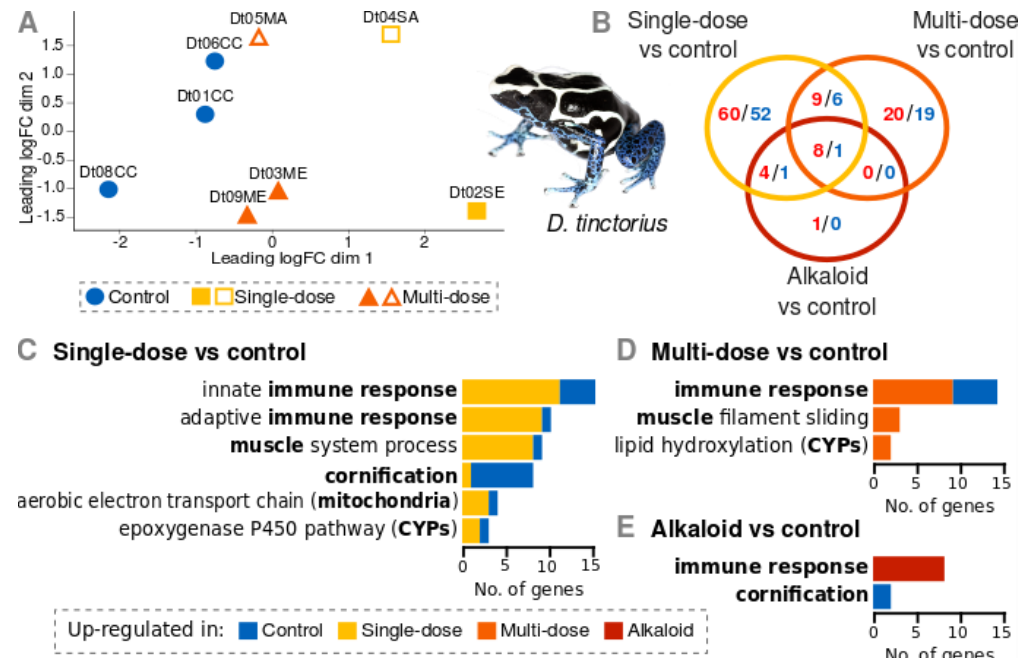
Figure 2. Gene expression of D. tinctorius upon a single dose or multiple doses of alkaloids. A. MDS plot showing the expression distances between samples coded by treatment. Distances were calculated from the logFC of the 500 transcripts with the highest standard deviations between conditions. Closed symbols = epibatidine. Open symbols = alkaloid mixture. B. Venn diagram showing the number of di ff erentially expressed genes found for the three comparisons single-dose vs. control, multi-dose vs. control, and alkaloid (i.e., single-dose and multi-dose) vs. control. Numbers in red indicate over-expression in the alkaloid treatment, and numbers in blue indicate over-expression in the control. C. Enriched biological process GO-terms for the single-dose vs control comparison D. Enriched biological process GO-terms for the multi-dose vs. control comparison. E. Enriched biological process GO-terms for the alkaloid vs. control